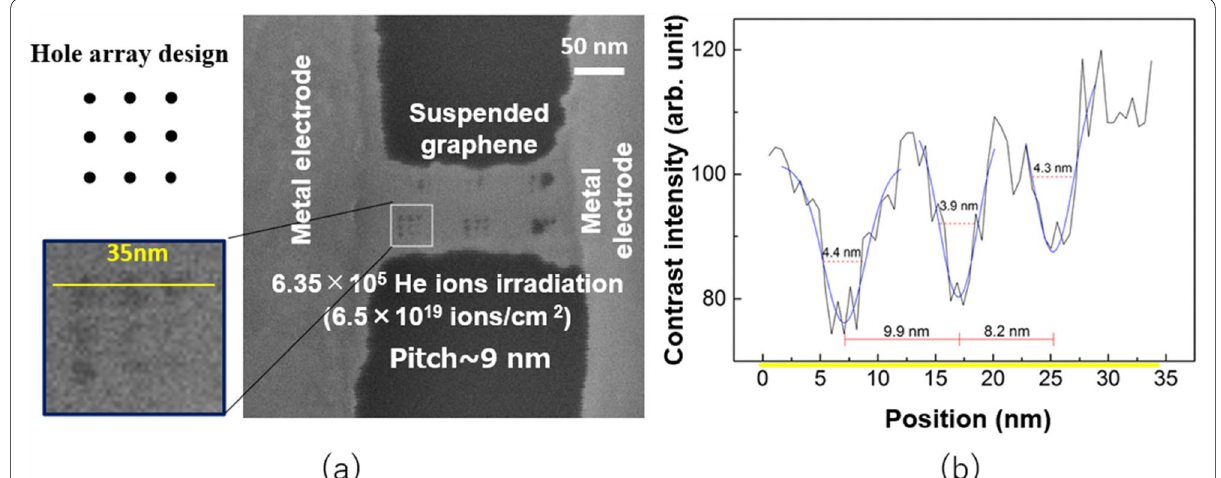
Fig. 8 a A HIM image of a nanopore array (indicated within the square) drilled using a dose of 6.35 along the yellow line in ( a ). These data indicate that a nanopore array with a diameter and pitch of approximately 4.2 nm and 9.0 nm, respectively, could be fabricated. Figure modified from